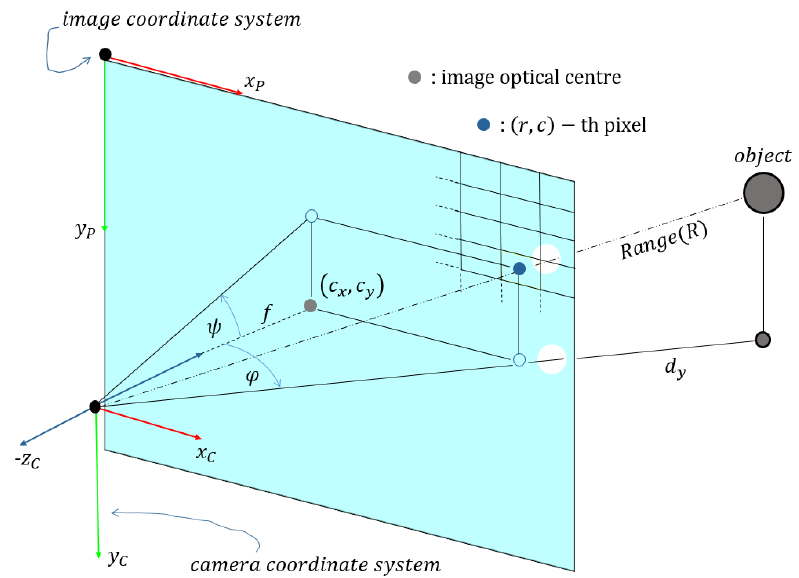
Figure 8. The triangulation technique as a tool for straightforward 2D point projection or simulation of the synthetic data.